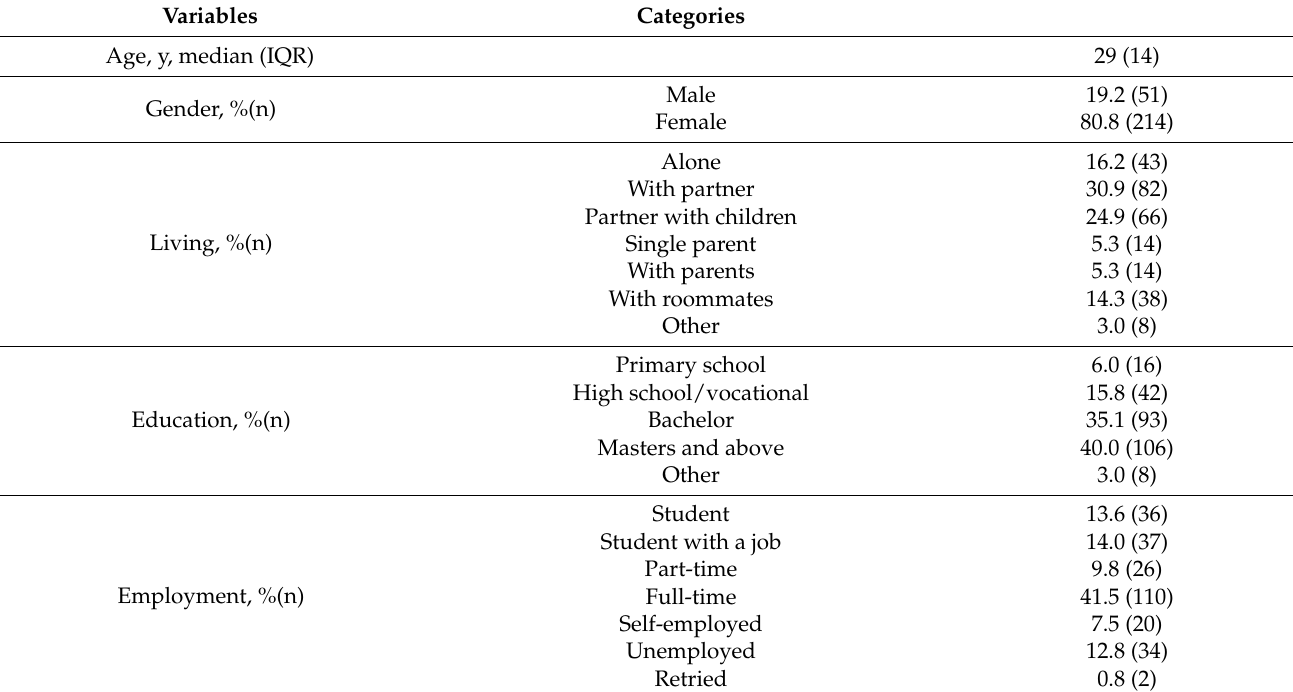
Table 1. Socio-demographic characteristics and lifestyle determinants, N = 265 a